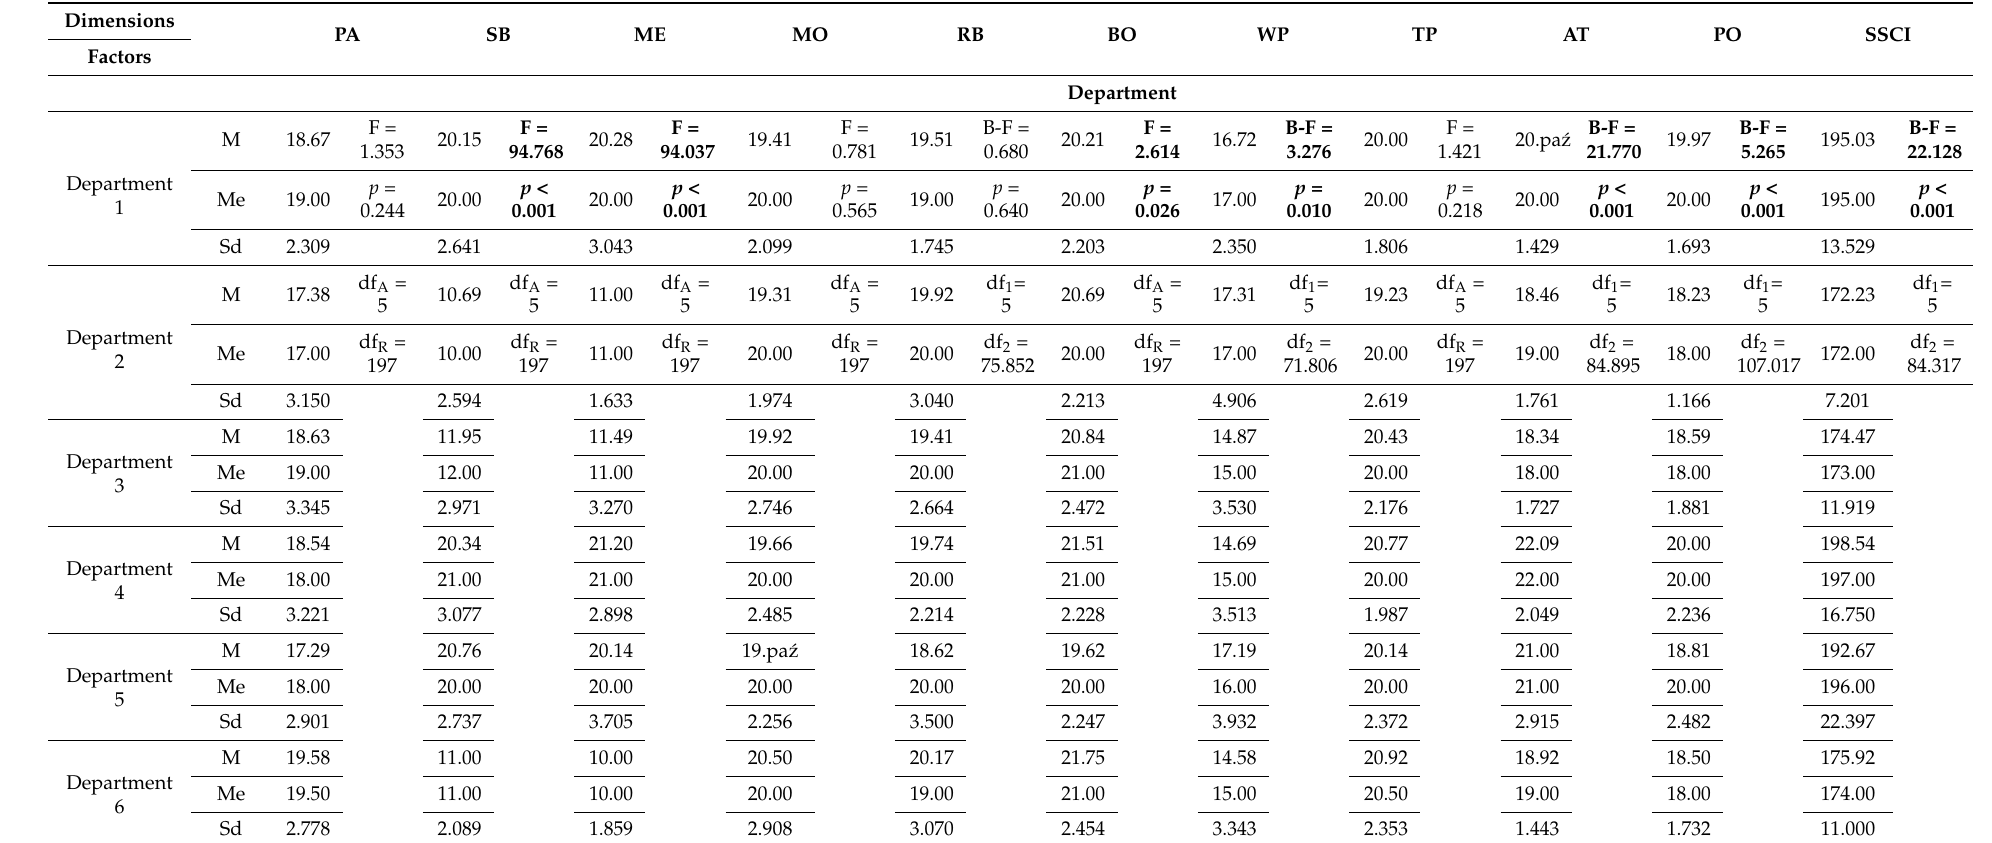
Table A1. The results of a single-factor analysis of variance